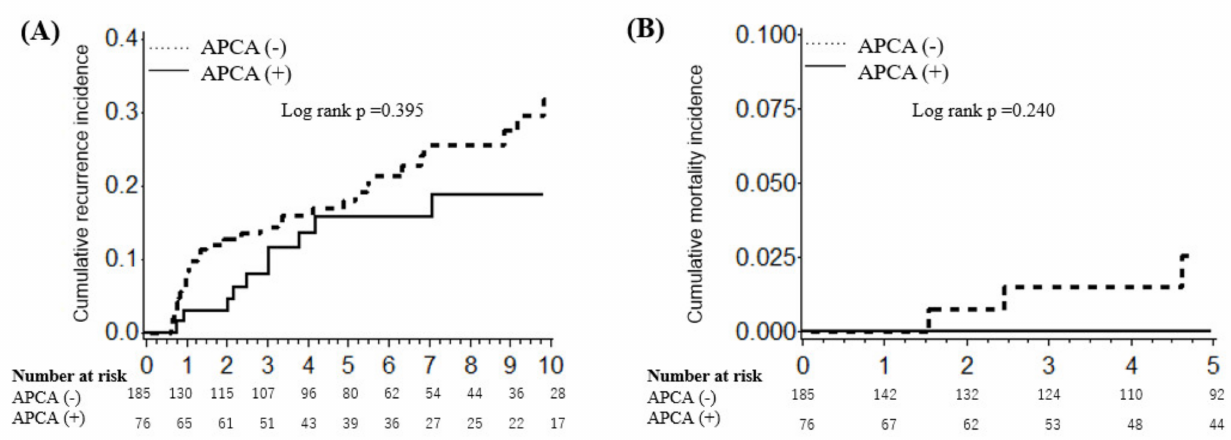
Figure 2. Cumulative incidences of ( A ) gastric cancer recurrence and ( B ) 5-year mortality in APCA- positive vs. APCA-negative patients. Survival analysis was performed using the Kaplan–Meier method and log-rank test. Abbreviation: APCA, anti-parietal cell